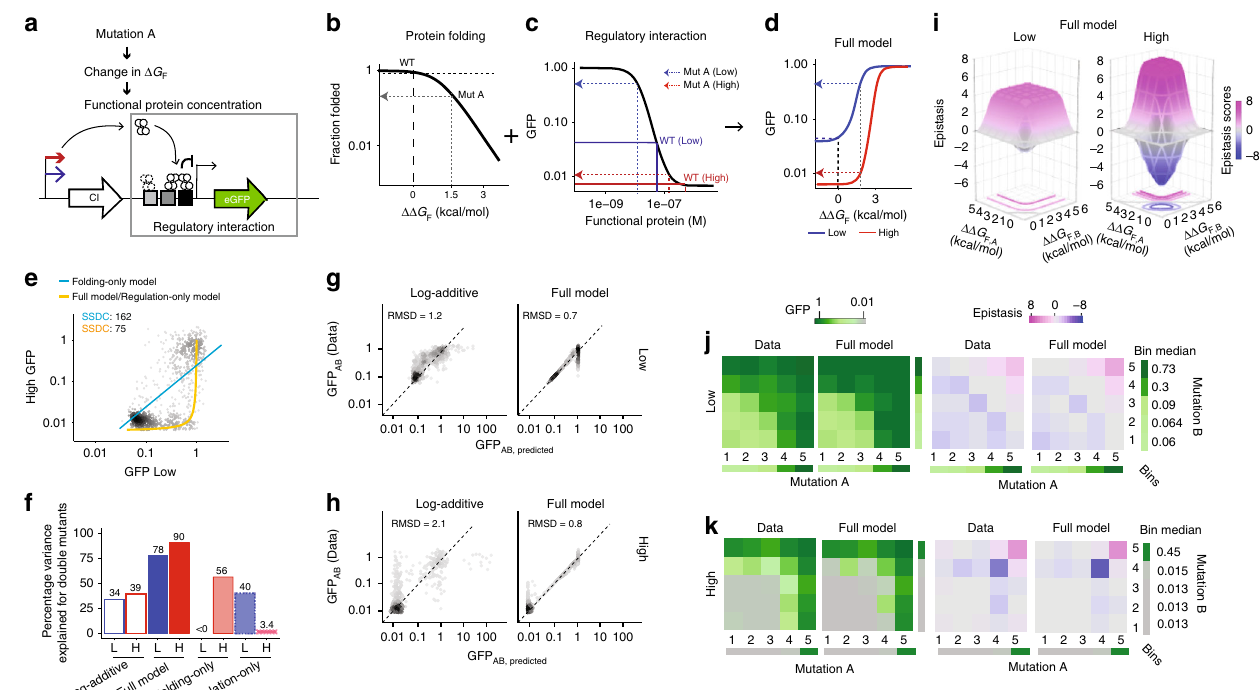
Fig. 3 Combined model of protein folding and regulatory interaction. a Mutations alter the free energy of protein folding ( Δ G F ) and so protein concentration and repression of the target gene. b – d Relationships between change in folding energy ( ΔΔ G F ) and the fraction of folded protein ( b ), protein concentration and target gene expression ( c ), and change in folding energy ( ΔΔ G F ) and target gene expression at low (blue) and high (red) expression ( d ). The effect of an example mutation ( a ) is indicated on each graph. e Regulatory interaction-only but not the protein folding-only model predicts the inverse relationship between target gene expression at the two expression levels. SSDC: sum of the squared distance from the curve. f Percentage of variance explained for double mutations for each model. ‘ L ’ indicates low expression and ‘ H ’ indicates high expression of CI. g , h Observed vs. predicted target gene expression for the log-additive and full folding + regulation model at low ( g ) and high ( h ) CI expression. RMSD: root-mean-square-deviation between the predicted and observed data. i Predicted epistasis at low and high expression for the full model. j , k Model-predicted and experimentally-observed target gene expression and epistasis when combining mutants at low ( j ) and high ( k ) expression. Mutations were ordered by their effects into fi ve equally populated bins and the median target gene expression and epistasis plotted for each bin in a region of yeast Hsp90 41 and also for human disease-causing variants 44 .